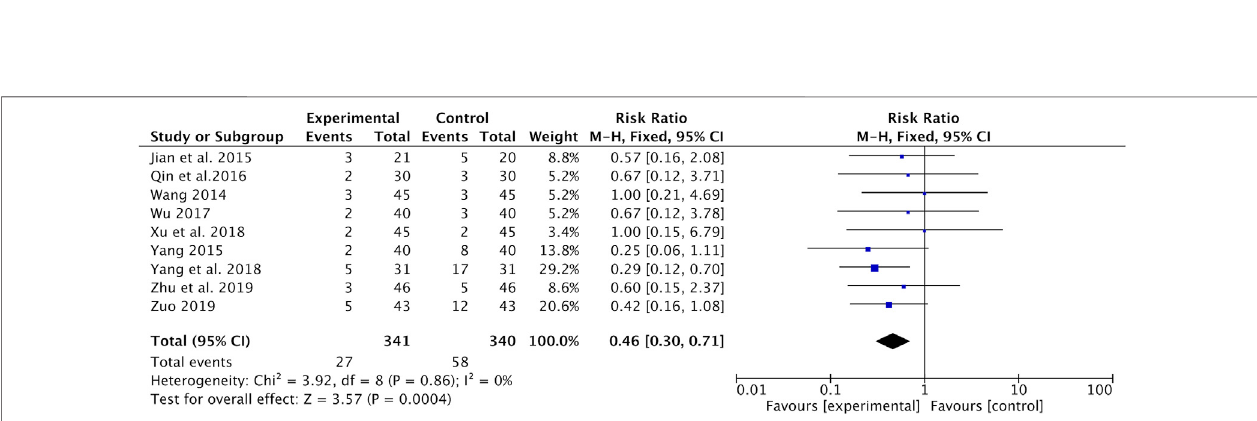
FIGURE 7 | Forest plot of neurotoxicity of Astragalus-containing CHM combined with CT vs. CT alone. CHM, Chinese herbal medicine; CT, chemotherapy.